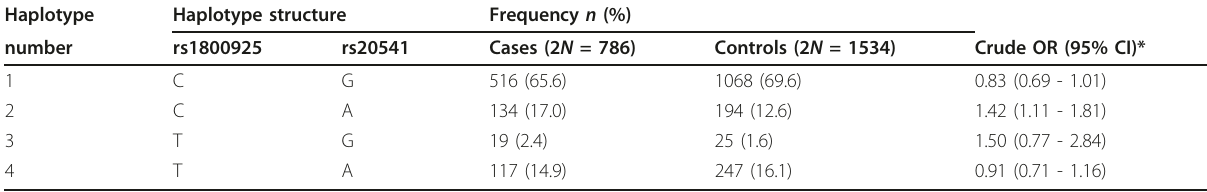
Table 4 Haplotype analysis of rs1800925 and rs20541 in relation to rhinoconjunctivitis in Japanese women, KOMCHS, Japan